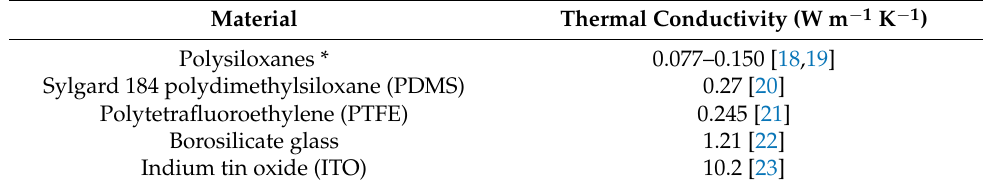
Table 1. Thermal conductivities of candidate substrate